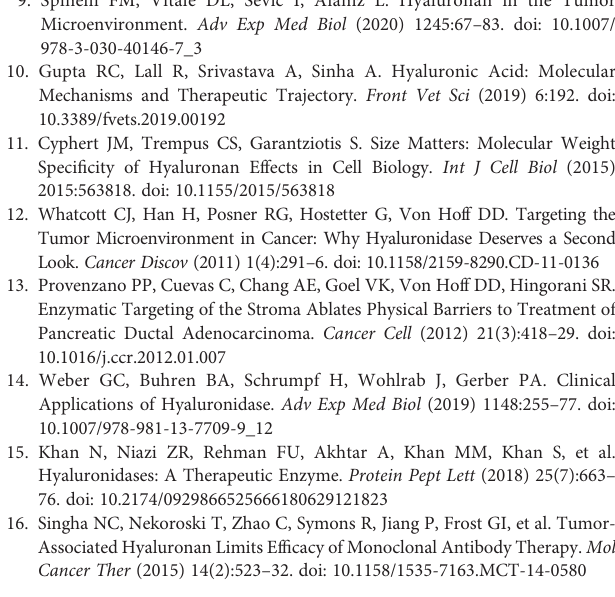
Supplementary Figure 1 | HA inhibits the transmigratory capacity of T cells in vitro . (A) Microscopy images of human T cells in the lower chamber of Transwell wells with different concentrations of HA (medium only, 1 mg/ml, 2 mg/ml, or 5 mg/ ml) at different timepoints (6 h, 12 h, and 24 h). (B) Cell counts for T cells in the lower chamber of Transwell wells with different concentrations of HA (medium only, 1 mg/ ml, 2 mg/ml, or 5 mg/ml). Error bars denote the S. D, and the results were compared with two-way ANOVA. *P<0.05, **P<0.01. Supplementary Figure 2 | Representative fl ow cytometry image of CAR expression ef fi ciency in transduced T cells. Supplementary Figure 3 | In vitro functional screening of PH20-overexpressing vectors. (A) Hyaluronidase activity of PH20-IgG2-, PH20-, sPH20-IgG2-, and sPH20-transduced Jurkat cells, untransduced Jurkat cells and a medium control at 24 hours. (B) Hyaluronidase activity of sPH20-IgG2-transduced Jurkat cells, untransduced Jurkat cells and the medium control at different timepoints (12h, 24h and 48 h). Error bars denote the S. D, and the results were compared with an unpaired t test. *P<0.05; **P<0.01, ***P<0.001. Supplementary Figure 4 | Expression of sPH20-IgG2 does not affect the normal effector functions of anti-MSLN CAR-T cells. (A) Flow cytometric analysis of untransduced, anti-MSLN CAR-transduced, and anti-MSLN-sP CAR-transduced T cells. (B) Results of a direct killing assay with Mock-T, anti-MSLN-T or anti-MSLN- sP-T cells and the target gastric cancer cell line BGC823GL. Error bars denote the S. D, and the results were compared with two-way ANOVA. (C) Secretion of IFN- g and Granzyme B by Mock-T, anti-MSLN-T and anti-MSLN-sP-T cells after coculture with BGC823GL cells for 24 h. Error bars denote the S. D, and the results were compared with an unpaired t test. n.s: not signi fi cant. Supplementary Figure 5 | (A) Flow cytometric analysis of fl ow sorted anti- MSLN-sP CAR-transduced T cells. (B) Hyaluronidase activity of Mock-T, anti- MSLN-T and anti-MSLN-sP-T cells after fl owcytometry sorting of CAR MSLN+GFP+ double positive population.Error bars denote the S. D, and the results were compared with an unpaired t test. *P<0.05; **P<0.01,